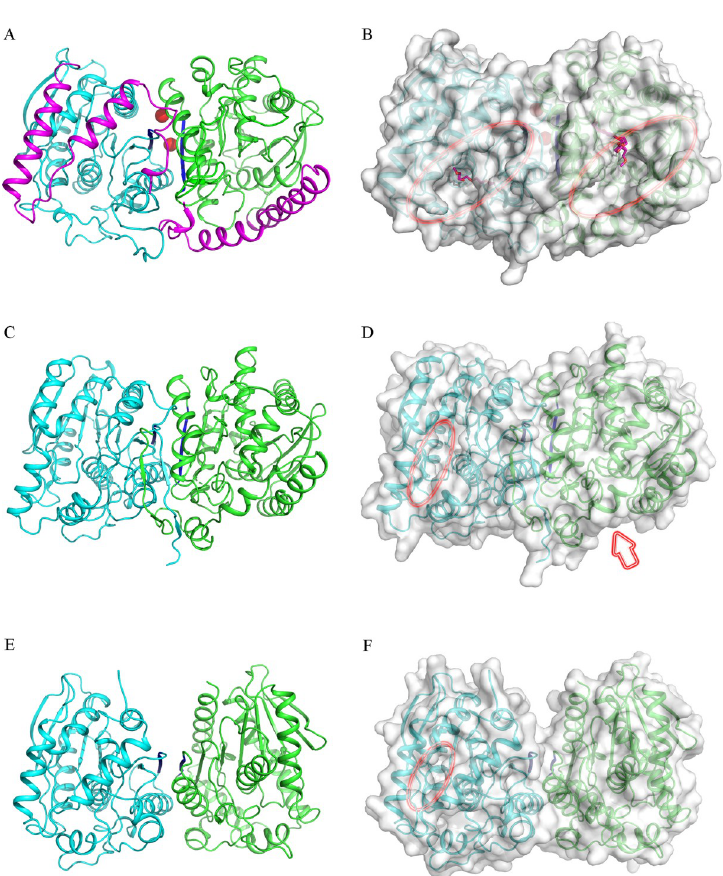
Fig 3. Comparison of the PMGL2 dimer with the dimers of homologous enzymes. (A) Cartoon representation of the mPMGL2 dimer. Enzyme subunits are highlighted in different colors. CAP-domains and β 8 strands are colored in magenta and blue, respectively. Magnesium ions are shown as red spheres. (B) Surface representation of the mPMGL2 dimer. Hereinafter orientation of the molecules and color scheme are the same as on the panel A. PEG molecules bound in the active site cavity are depicted in pink. Entrances to the active site are marked with red ellipses, reflecting their approximate size. (C) Cartoon representation of the 4Q05 dimer. (D) Surface representation of the 4Q05 dimer. The second entrance to the active site on the side of the molecule is marked with an arrow. (E) Cartoon representation of the 3K6K dimer. (F) Surface representation of the 3K6K dimer. The second entrance to the active site is not marked as it is situated on the opposite side of the molecule. Note that in this case, β 8 strands lie near in the same plane (are antiparallel).